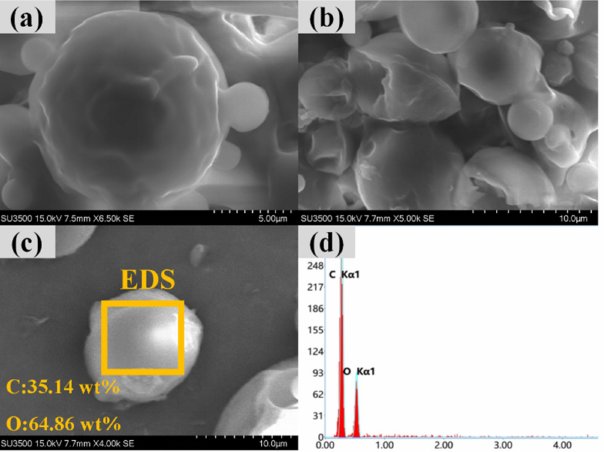
Figure 7. SEM micrographs of MPCM ‐ 1 (particle size < 200 mesh): ( a ) ×6500 and ( b ) ×5000. ( c ) EDS analysis. ( d ) Surface element content of MPCM ‐ 1.